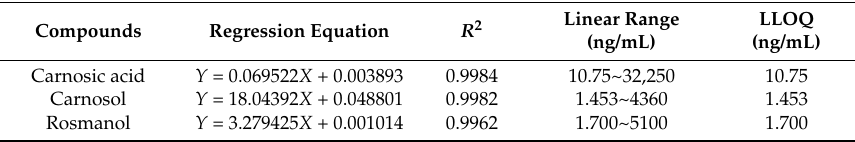
Table 2. The regression equations, linear ranges and LLOQs for the determination of the analytes in rat